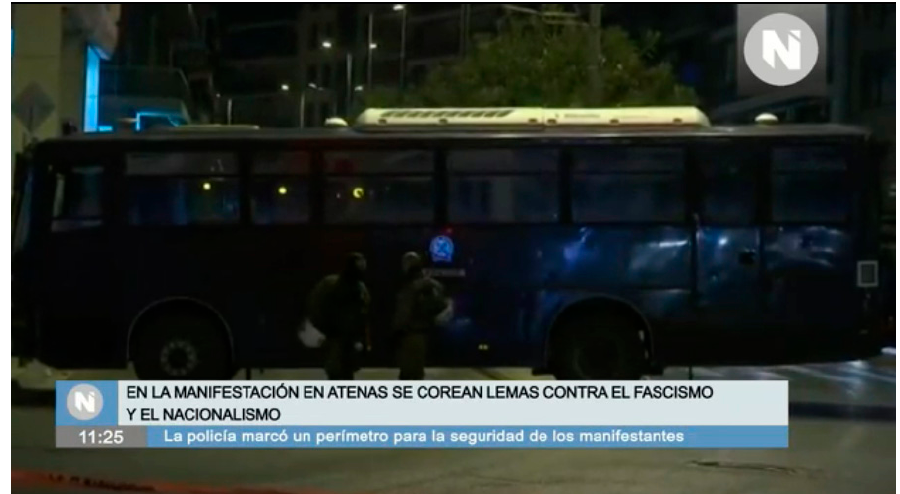
Figure A1. Sample of the news item on the far right in digital television format.